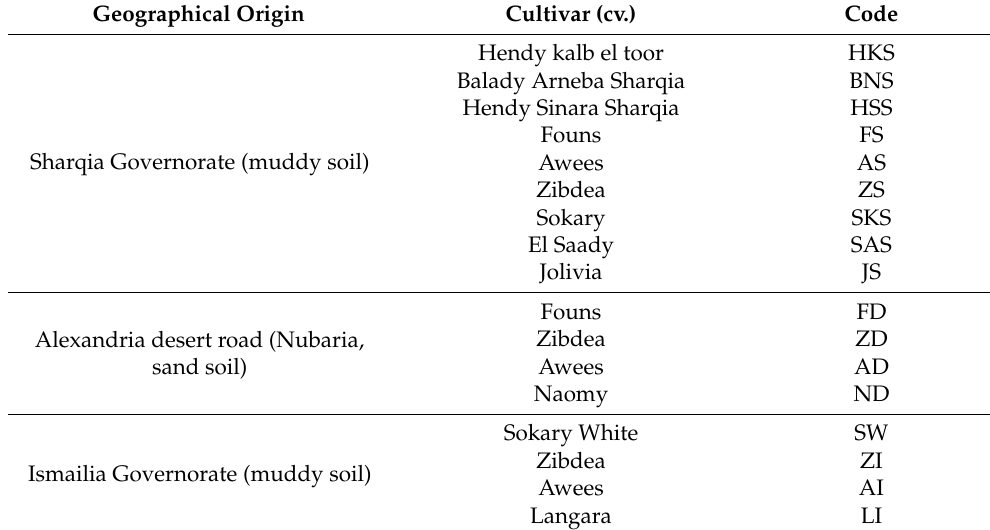
Table 1. Mango fruit cvs. and their geographical locations in Egypt from which samples were collected. Mango codes used within the manuscript are listed in the table by two- to three-letter codes, while the locations of collections are shown in Supplementary Figure